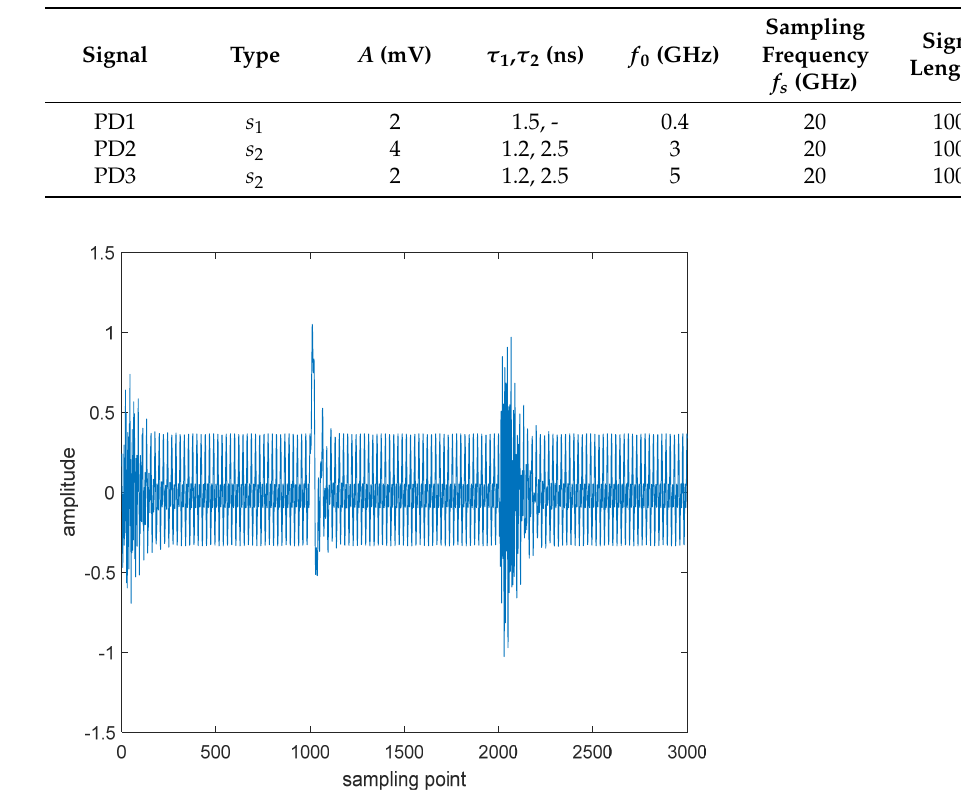
Table 1. Parameters of DEP and DOP signals.